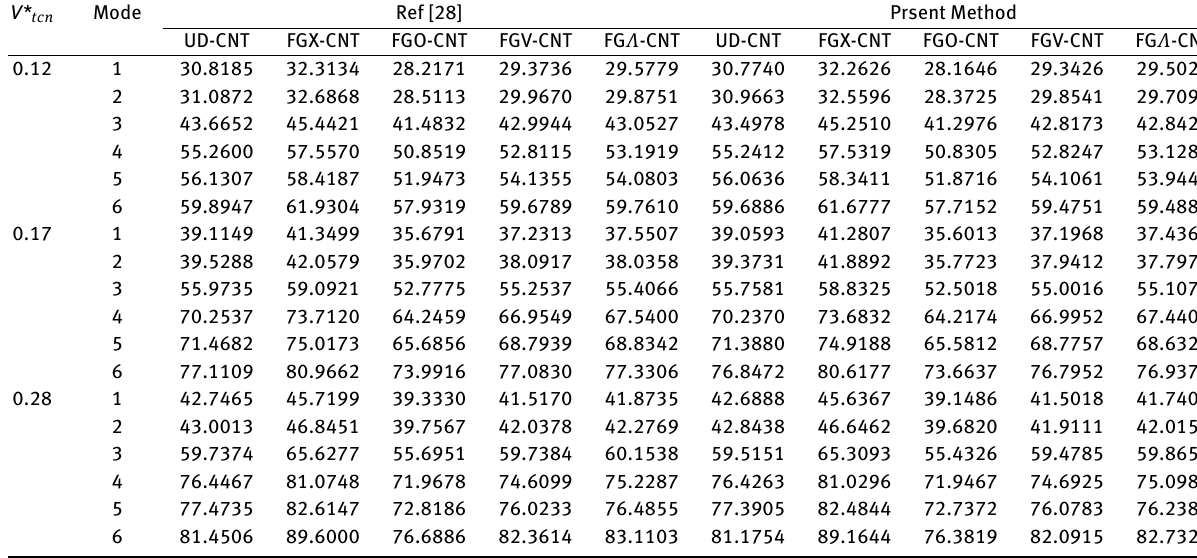
Table 2: Comparison of the frequency parameters Ω for a FG-CNT reinforced composite panel with CCCC boundary condition. V* tcn